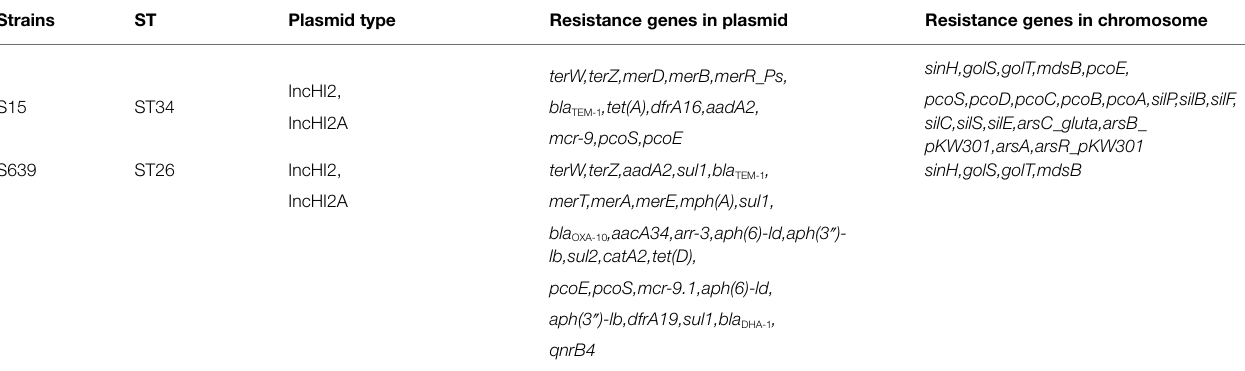
TABLE 3 | Resistance genes in two strains.